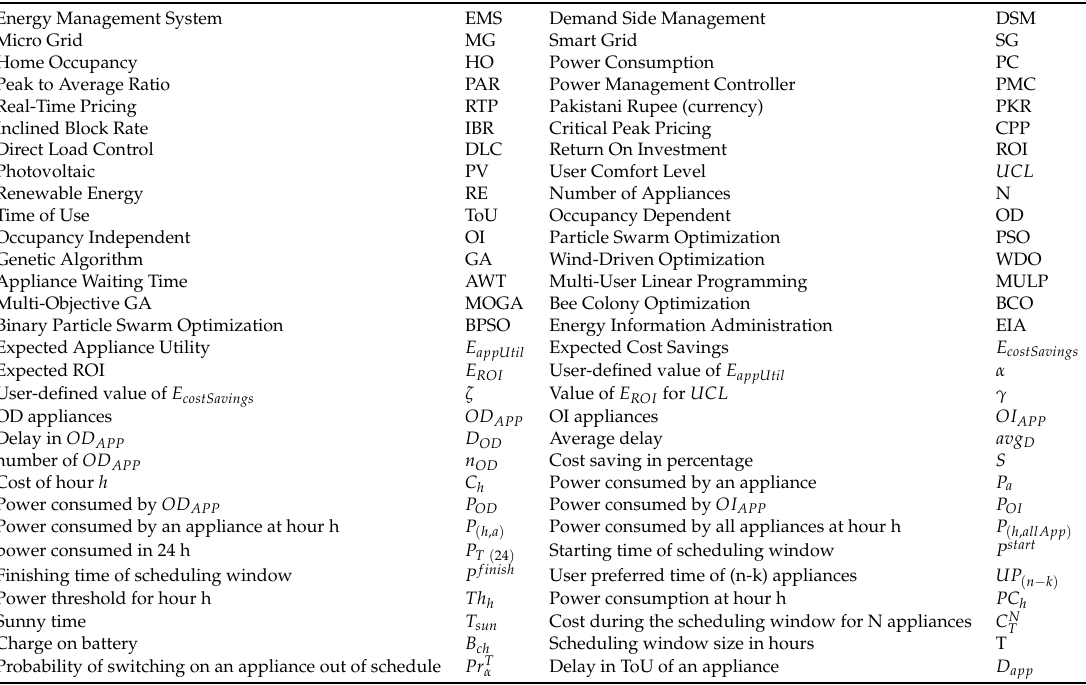
Table 1 represents the list of abbreviations and mathematical notations used in this work. Table 1. Abbreviations, symbols and mathematical